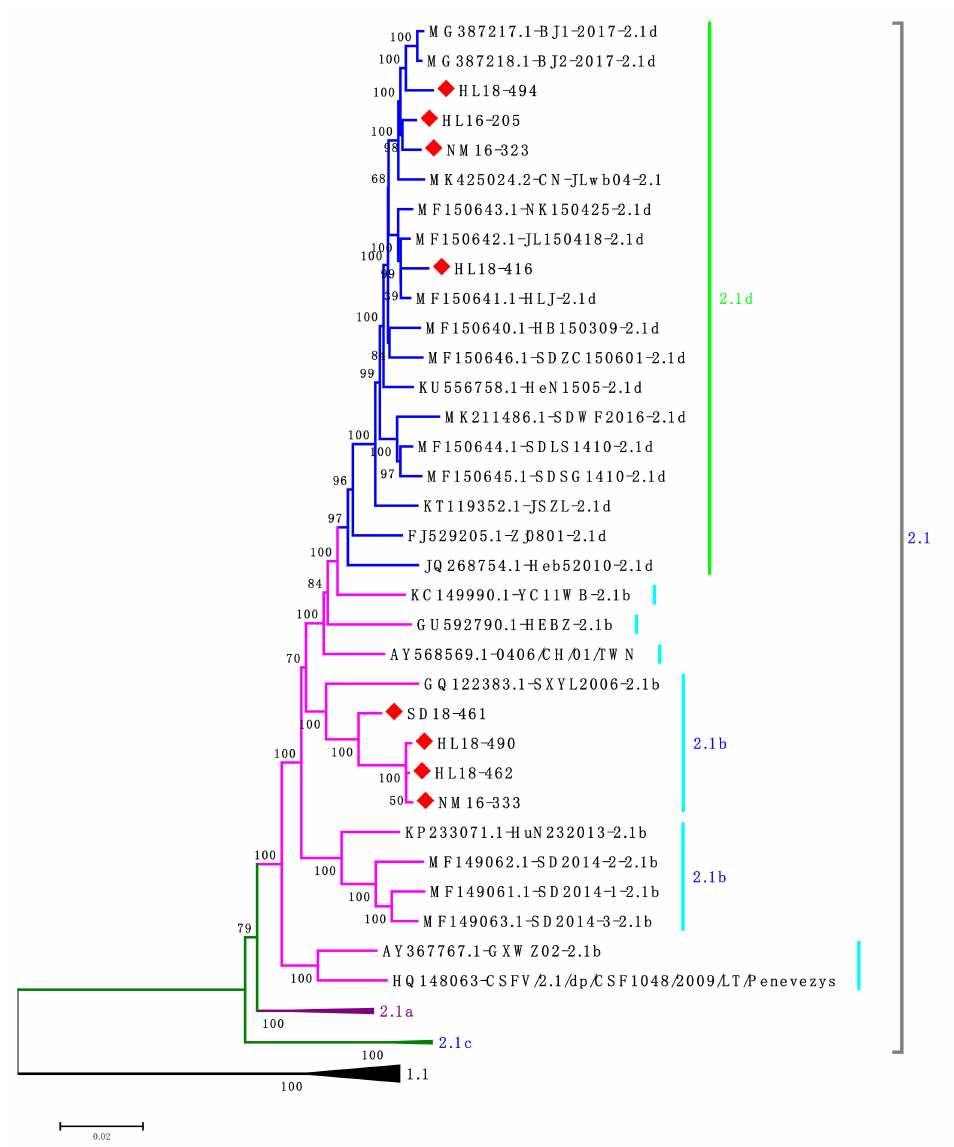
Figure 3. Phylogenetic tree based on the complete genome sequences of CSFV strains using the neighbor-joining (NJ) method, with 1000 bootstrap replicates. All new isolates were indicated by red diamonds, in which the subgenotype 2.1d isolates were indicated in pink while subgenotype 2.1b isolates were indicated in